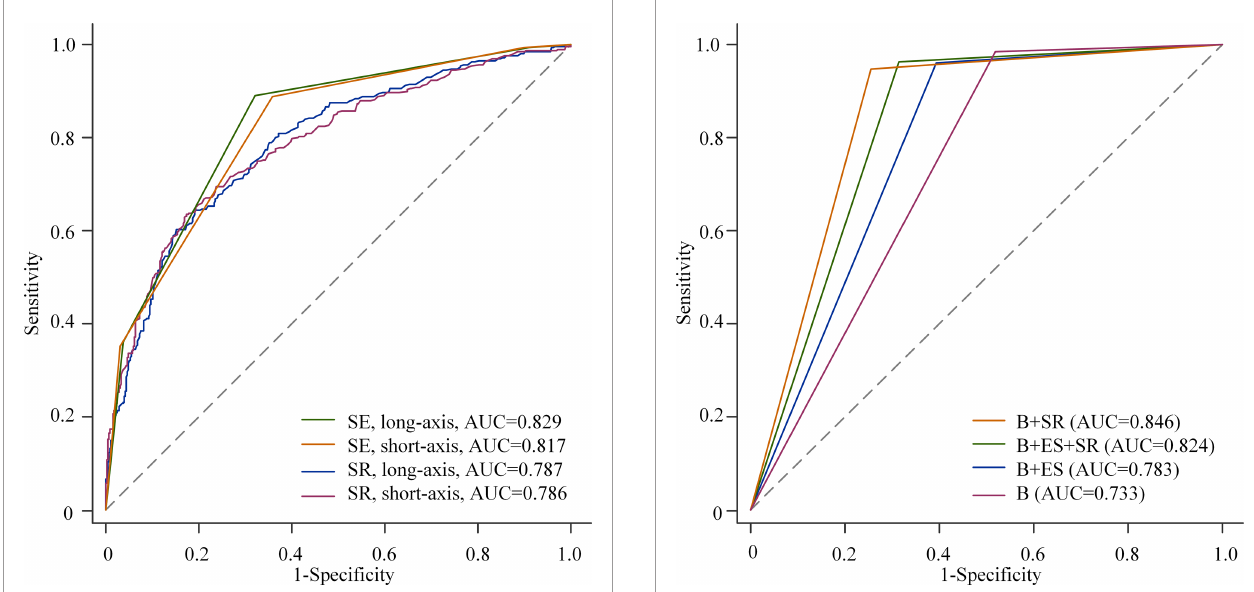
FIGURE 4 | Receiver operating characteristic (ROC) curves for elasticity score (ES) and strain ratio (SR) in different planes.